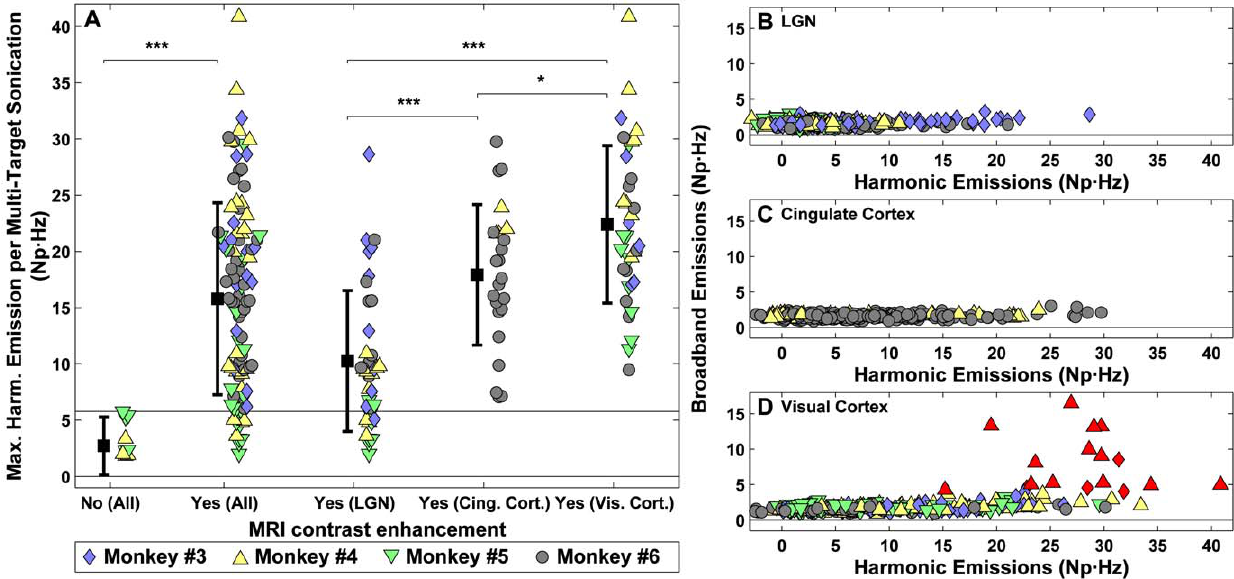
Figure 5. Harmonic emissions predict BBB disruption and safety limits. (A) Maximum harmonic emission signal strength achieved during 104 multi-target sonications that did and did not result in MRI contrast enhancement. Sonication at different tissue structures produced different levels of harmonic emissions (*P , 0.05; ***P , 0.001). The greatest harmonic emissions were measured during sonication in the visual cortex. Contrast enhancement was always observed when the harmonic signal strength was 6 Np ? Hz or higher. (B–D) Broadband emission plotted as a function of harmonic signal strength for 1026 subsonication targets in the three tissue structures. Red symbols indicate subsonications where the SNR of the broadband emissions signals was greater than 3. Such emissions were only observed in sonications in the visual cortex, and with one exception, only occurred when the harmonic emissions strength was greater than 20 Np ? Hz.